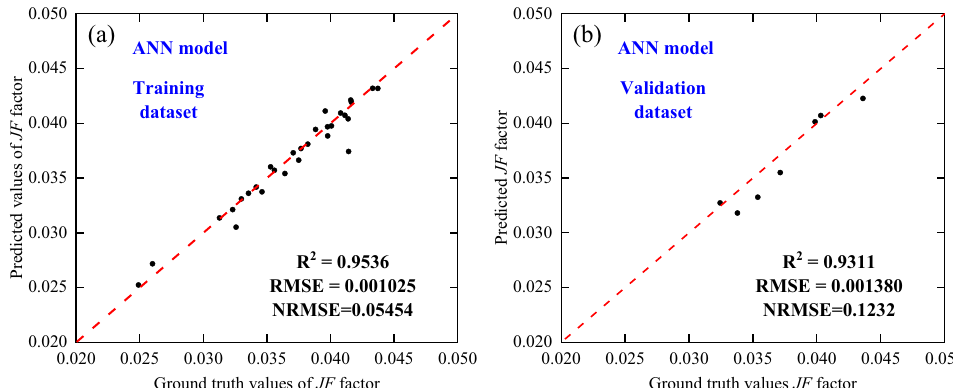
Figure 8 Comparison of predicted and simulated values of JF